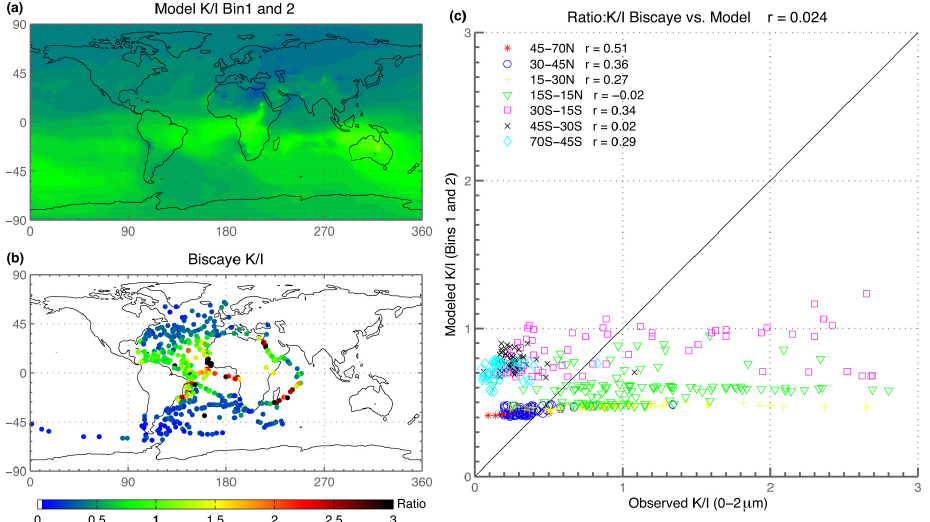
Figure 7. Kaolinite/illite mineral ratio of wet and dry deposition for bin 1 and bin 2 from CAM4 (a) (kgK / kgI) and from characteristic basal X-ray diffraction maxima ratios of K / I of ocean core sediments (b) (Biscaye, 1965). Data are segregated by latitude bands in scatterplot (c)